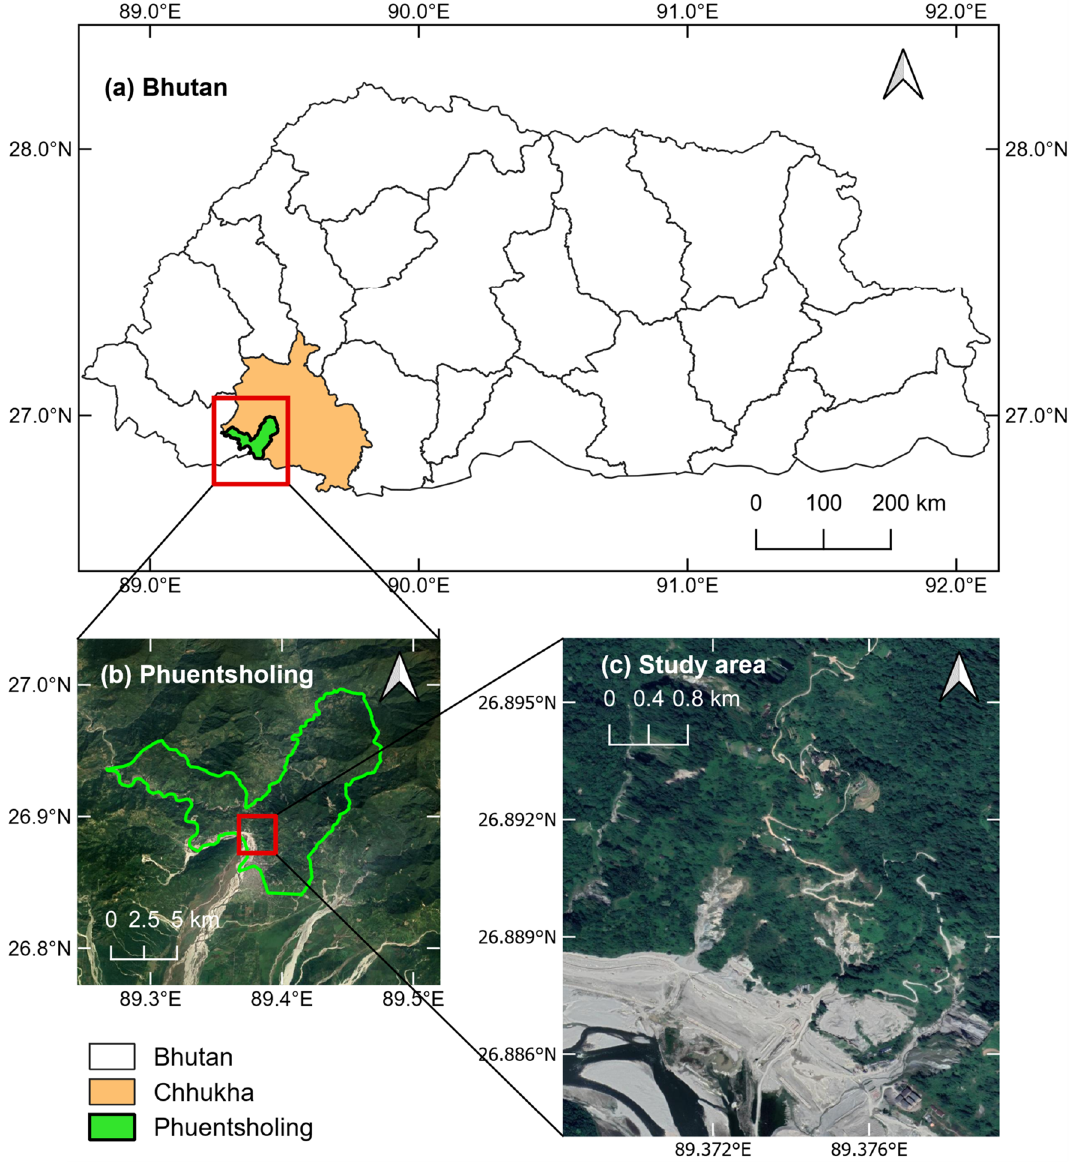
Fig. 1 Geographical location of the study area: a Bhutan administrative units, b Location of the Phuentsholing area under Chhukha district, c Study area location, an extended Phuentsholing township